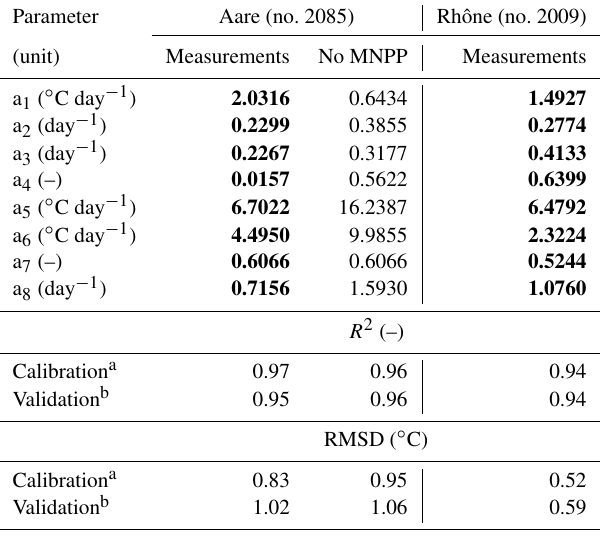
River temp. model River temp. observations Air temp.